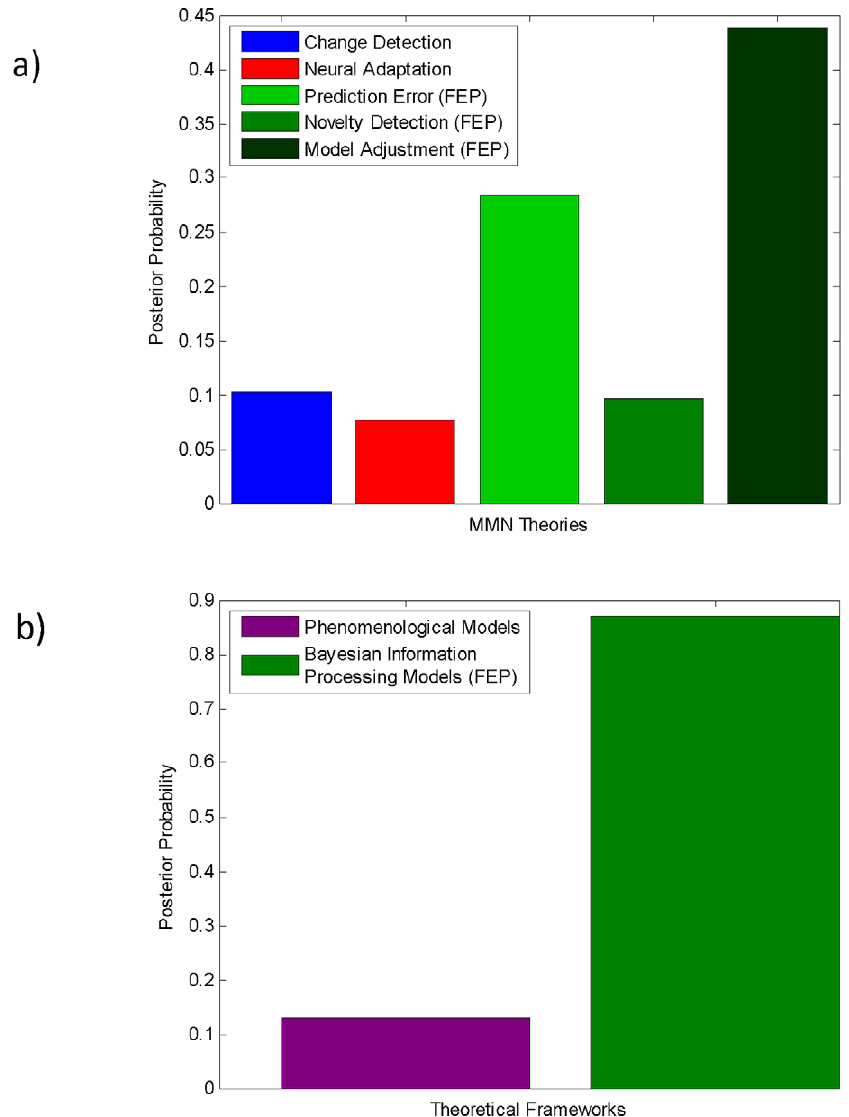
Figure 5. Bayesian model comparison of the five MMN theories (a) and the two frameworks (b). The bar plot in the upper panel (a) summarizes the comparison of the five model families in terms of their posterior probabilities. Each bar indicates the posterior probability of a particular MMN theory (i.e. P(fam CD D Y ), (cid:2)(cid:2)(cid:2) ,P(fam adjustment D Y ) ). The most plausible explanations of our trial-wise MMN data were provided by the model adjustment hypothesis ( P(fam adjustment D Y ) & 0 : 44 ) and the prediction error hypothesis ( P(fam PE D Y ) & 0 : 28 ). The lower panel (b) shows the results of comparing phenomenological ( fam pheno ) vs. free-energy based models ( fam FEP ); see Figure 2. It shows that our free-energy based models provide considerably more convincing explanations of our MMN data than traditional change detection or adaptation models ( P(fam FEP D Y ) ~ 0 : 87